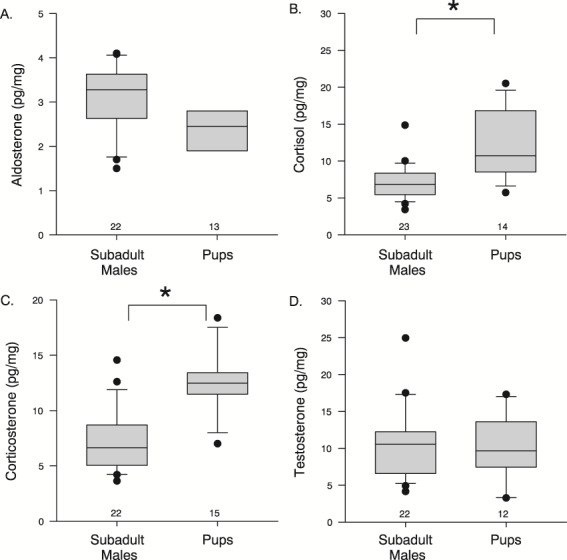
Concentrations of (A) aldosterone, (B) cortisol, (C) corticosterone, and (D) testosterone in subadult male northern fur seals and pups. There were no differences in hormone concentrations between male and female pups. * denotes significant differences found between groups and sample size noted on each graph. Box plot: grey box includes data between the 25th and 75th percentile, with a line within each box denoting the median, the whiskers denote the error bars (10 and 90% percentile), and the circles denote outliers